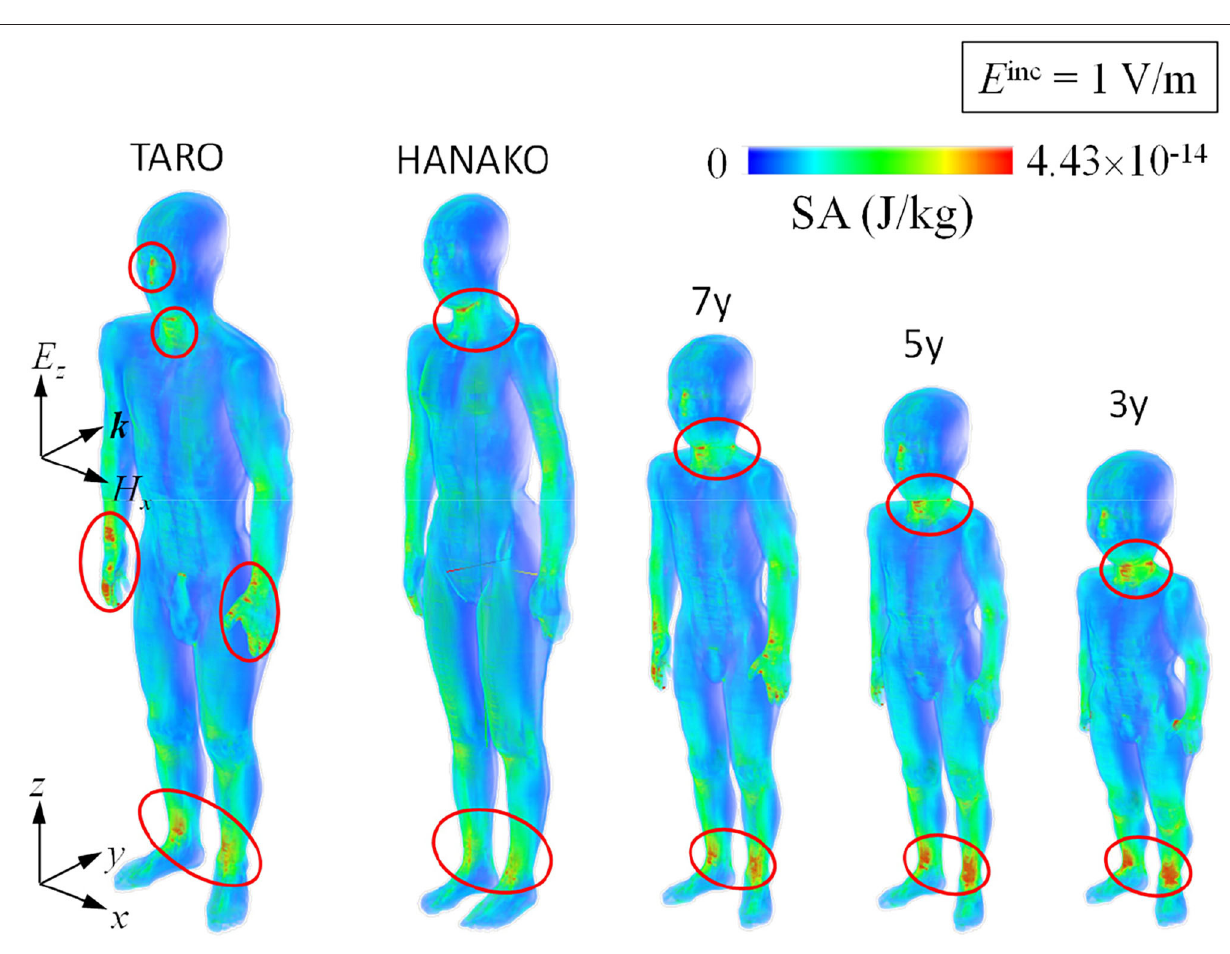
Frontiers in Public Health |